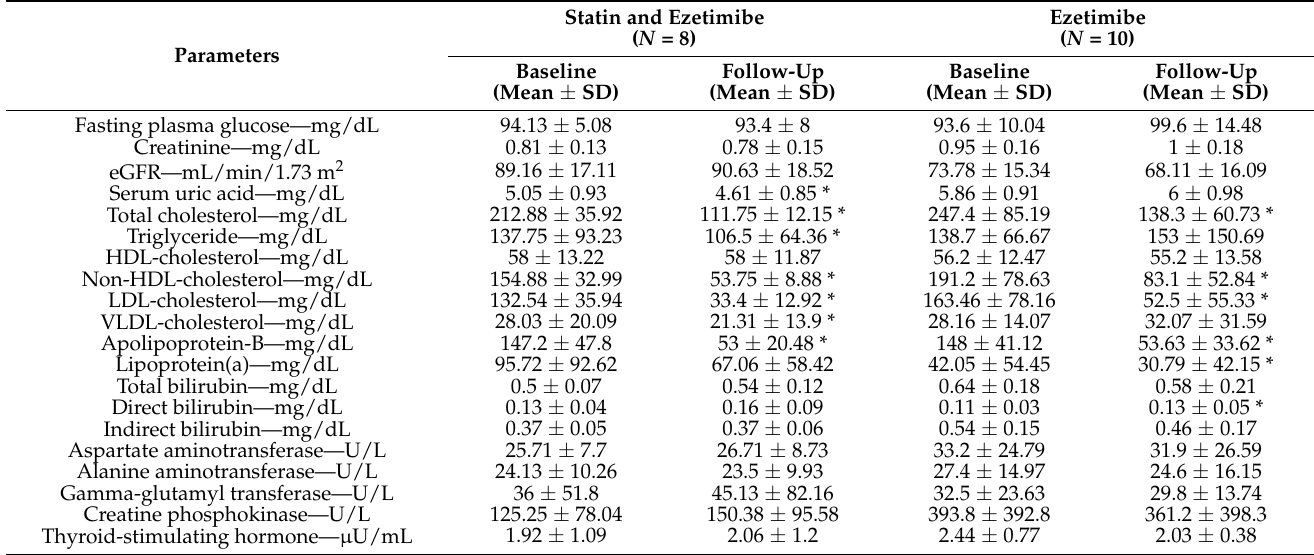
Table 2. Laboratory data of the patients undergoing treatment with Evolocumab.